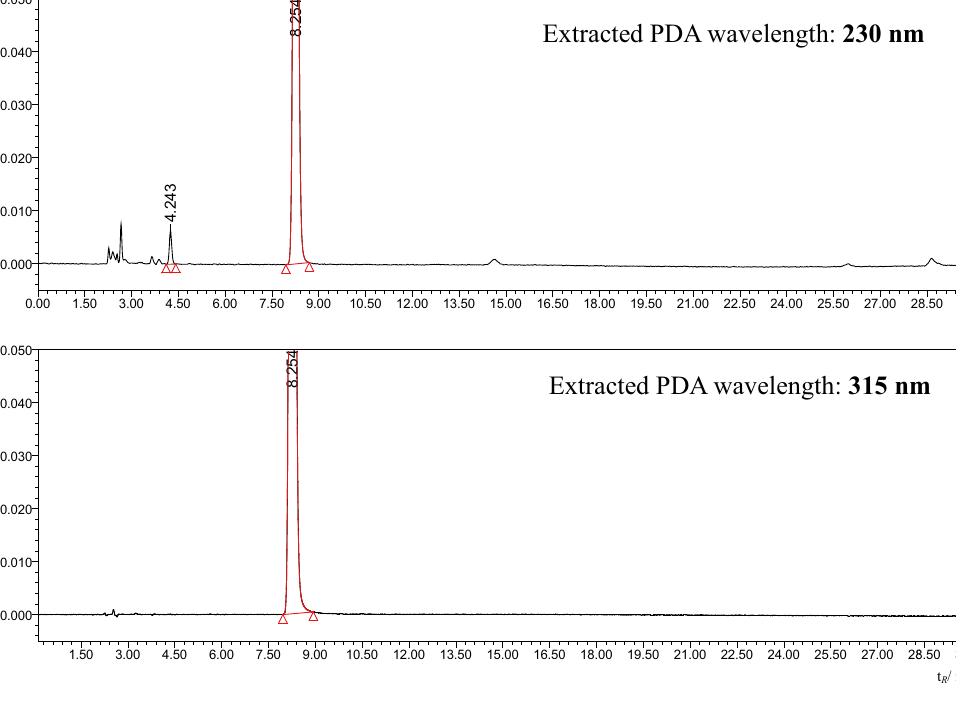
Figure 4. Comparison of chromatograms for light stressed metronidazole in solution (5000 lx, 24 h), with detection at 230 nm and 315 nm, respectively, by LC-PDA